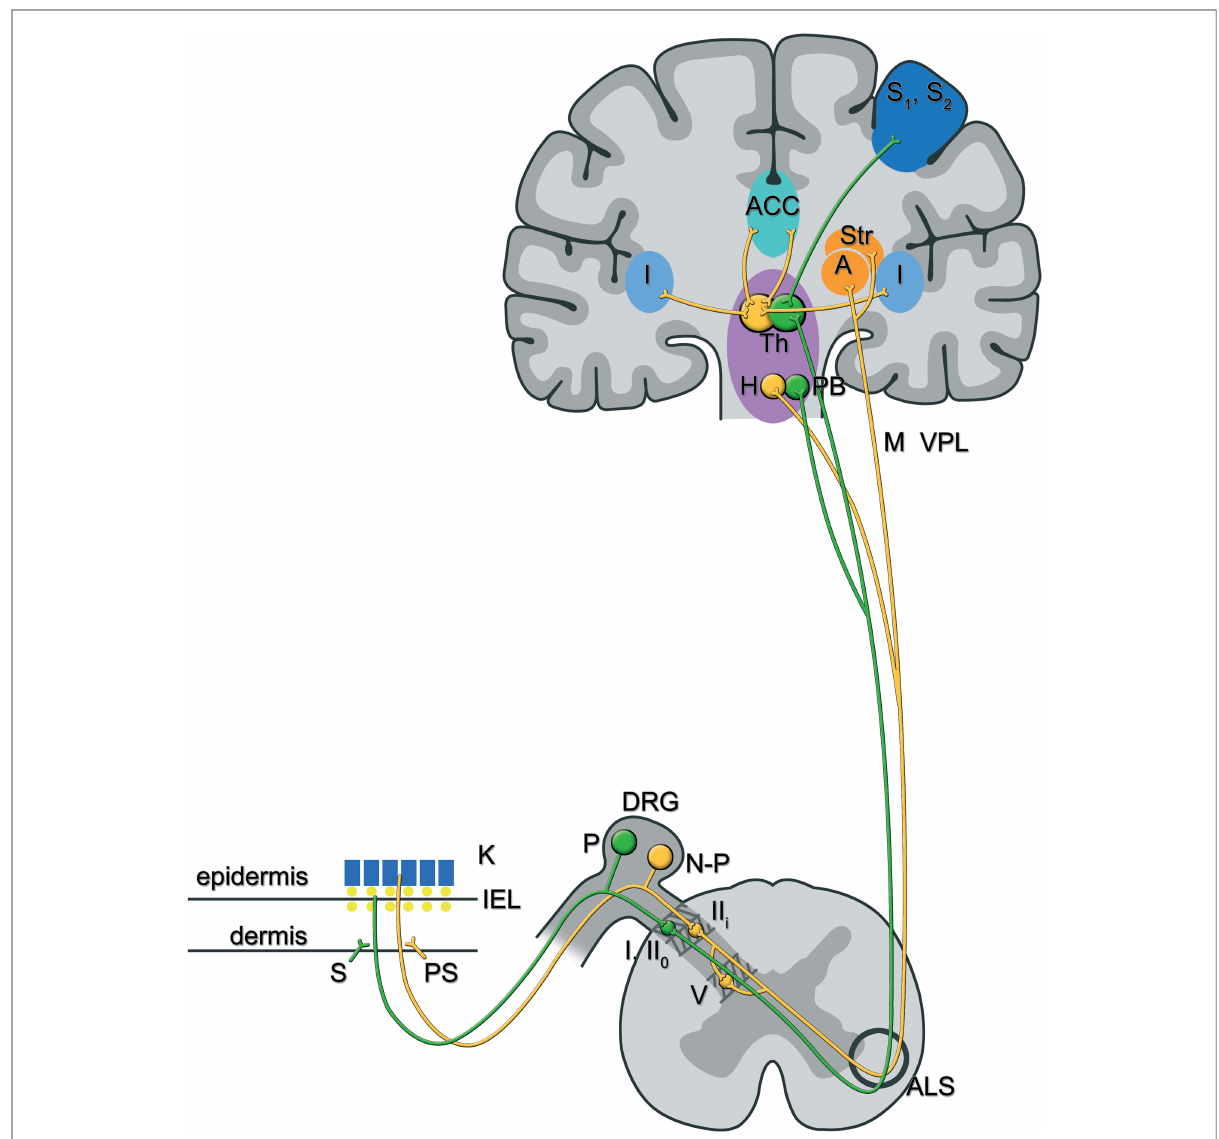
FIGURE 2 The lateral and medial pain ascending pathways in chemotherapy-induced peripheral neurotoxicity: afferents of peptidergic and non-peptidergic C- fi bres that form free nerve endings in the skin terminate in the super fi cial lamina of the spinal dorsal horn. In particular, peptidergic C- fi bres synapse on lamina I and lamina II o neurons, whereas non-peptidergic C- fi bres synapse on lamina II i (inter)neurons (39). Those second order pain neurons ascend, directly (lamina I and II o neurons) (38) or indirectly (lamina II i neurons, mostly via neurons in lamina V) (36), through the anterolateral system and project to brainstem and forebrain areas, amongst others the parabrachial nuclei and thalamus for peptidergic input, versus the amygdala, hypothalamus and striatal nuclei for non-peptidergic input. Functional MRI and PET studies have shown that separate brain areas process distinctive pain components: sensory-discriminative aspects of pain are processed in the contralateral primary and secondary sensory cortex, while affective components are processed in the hypothalamus, the contralateral amygdala and bilateral anterior cingulate cortex and insula (40, 41, 45). It is suggested that the pathway originating from peptidergic primary afferents (also called the lateral pain system-in green) contributes to the sensory-discriminative aspect of pain, while the pathway originating from non-peptidergic primary afferents (also called the medial pain system-in yellow) contributes to the affective component of the pain experience (34, 38, 39). In line with the clinical observation that patients with CIPN more often complain about unpleasant than about intense pain sensations, the non-peptidergic or lateral pain system may predominate in those patients (27, 32, 42). Abbreviations: K, keratinocytes; S, sympathetic; PS, parasympathetic; DRG, dorsal root ganglion; P, peptidergic sensory neuron; N-P, non peptidergic sensory neuron; I, lamina I of the dorsal horn; II o , outer part of lamina II of the dorsal horn; II i , inner part of lamina II of the dorsal horn; V, lamina V; ALS, anterolateral system; PB, parabrachial nuclei; Th, thalamus; H, hypothalamus; Str, striatal nuclei; S1, S2, somatosensory (association) cortex; A, amygdala; ACC, anterior gyrus cinguli; I,